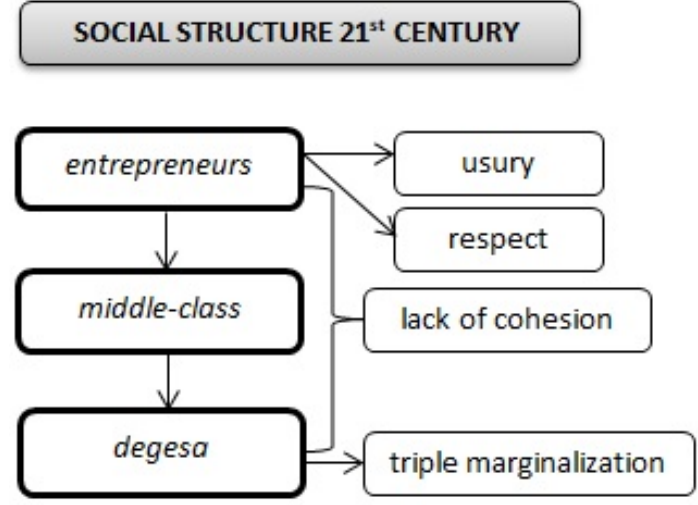
Figure 6. Social structure nowadays.